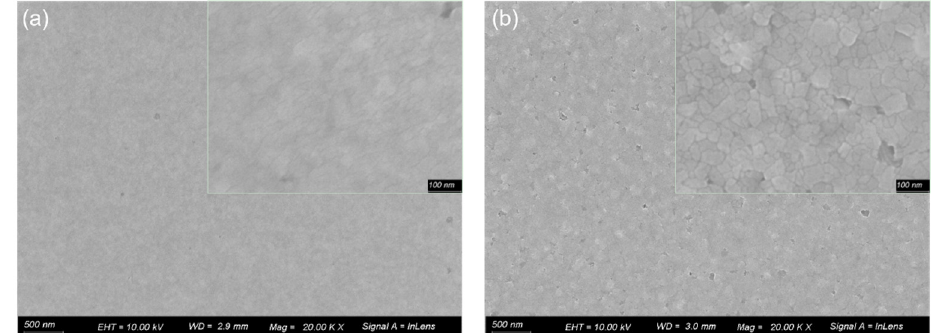
Figure 7. SEM images of ( a ) PEABr and ( b ) m -FPEABr perovskite films.